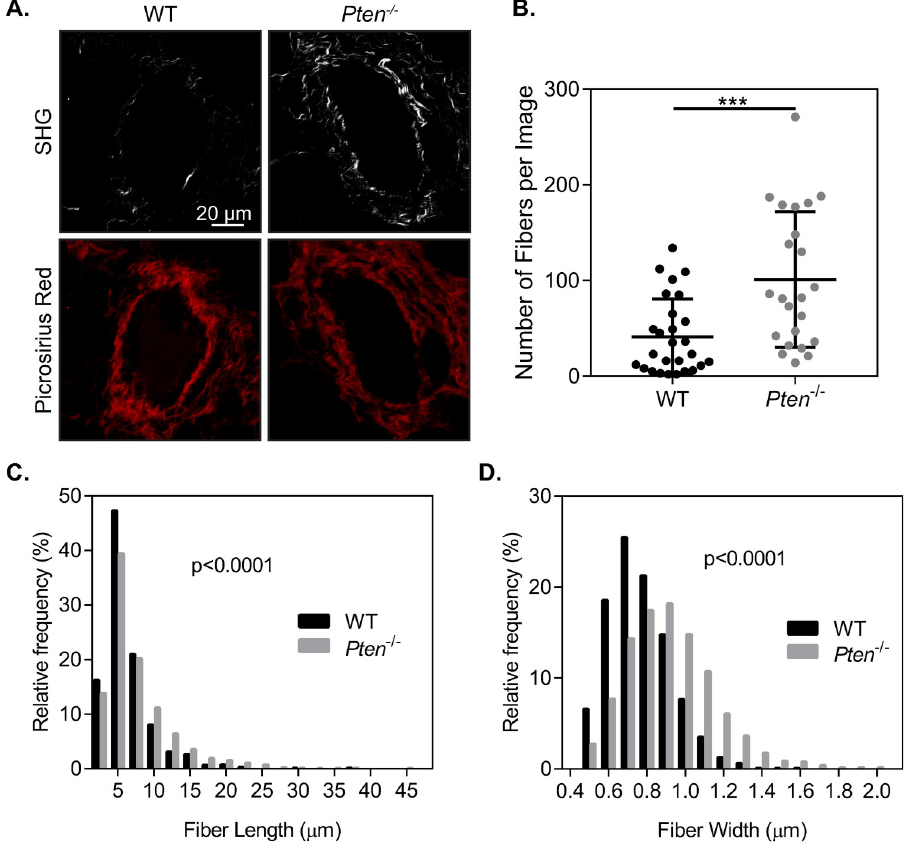
Fig 1. Pten knockout increases collagen fiber formation. (A) Second harmonic generation (SHG) and picrosirius red staining surrounding ducts in murine mammary tissue sections. SHG images are shown above their corresponding picrosirius red images. (B) Quantification of the number of collagen fibers in SHG images, shown as mean+SD with individual values plotted, n = 32 ducts imaged across 7 WT mice, 23 ducts imaged across 5 Pten -/- mice. (C) Histogram of collagen fiber length in SHG images. (D) Histogram of collagen fiber width in SHG images. ��� p < 0.001.